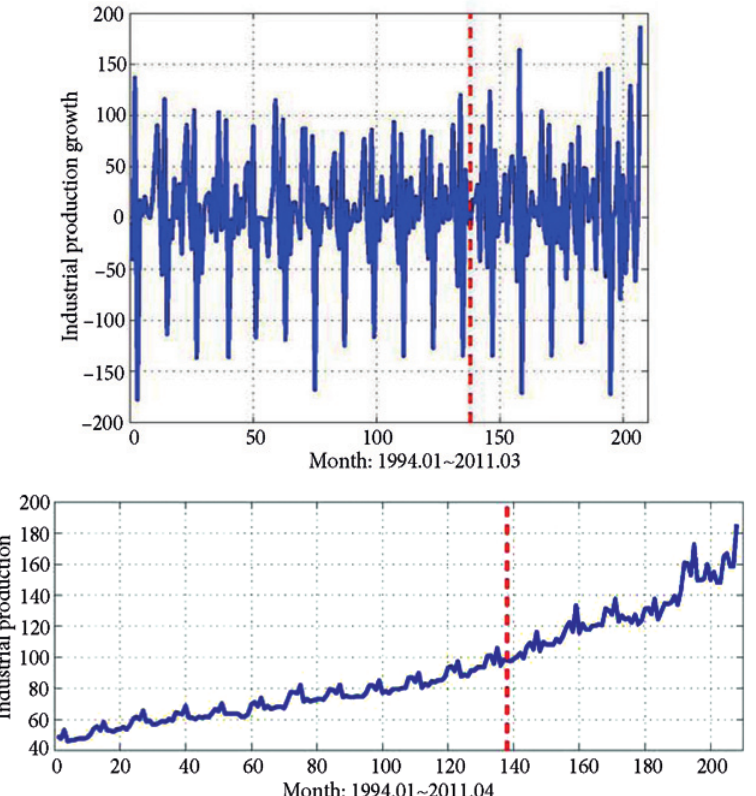
Fig. 1. Industrial production in levels and growth